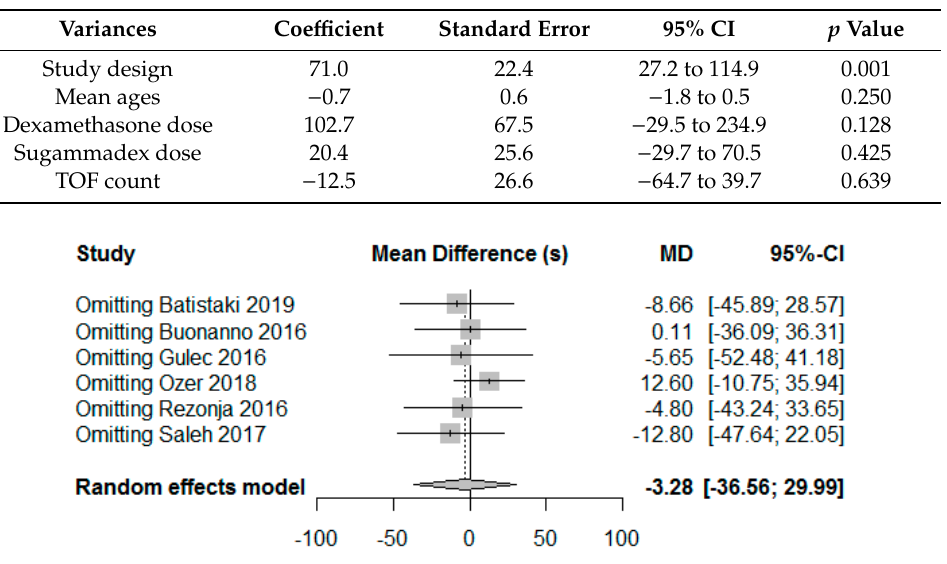
Figure 3. Sensitivity analysis by excluding one trial at time(s) to recovery of TOF ratio > 0.9 Table 2. Meta-regression for the potential sources of heterogeneity.